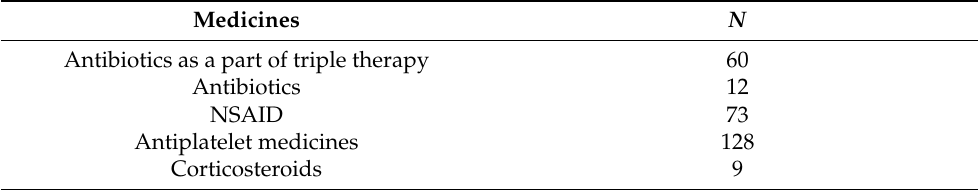
Table 7. The most dispensed medicines together with PPIs. Medicines